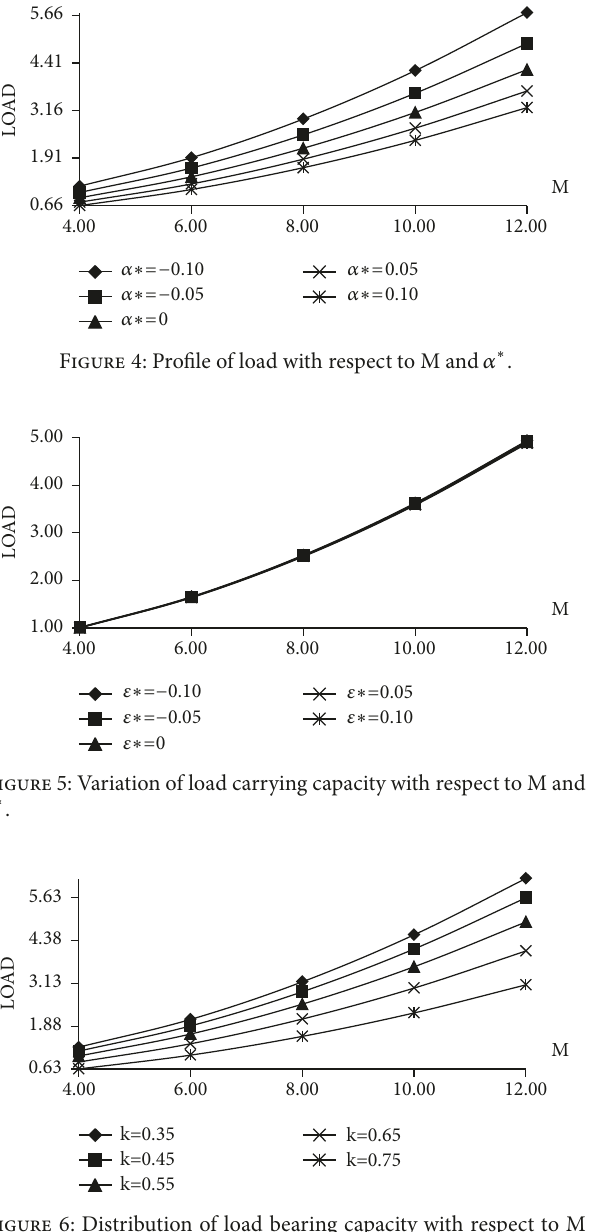
Figure 10: Profile of load with respect to 𝜙 0 + 𝜙 1 and k.